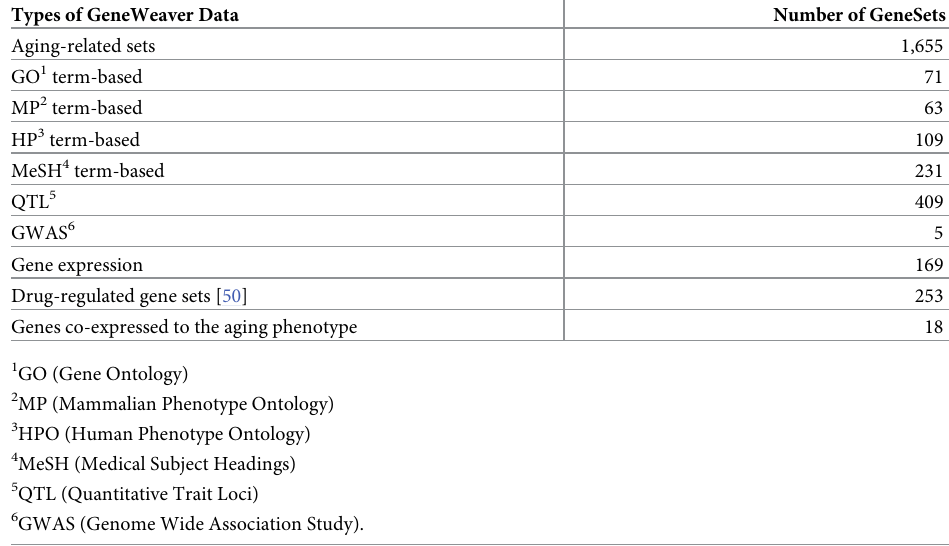
Table 1. Summary statistics on a search of GeneSets, genes, or ontologies for “senescence OR aging OR